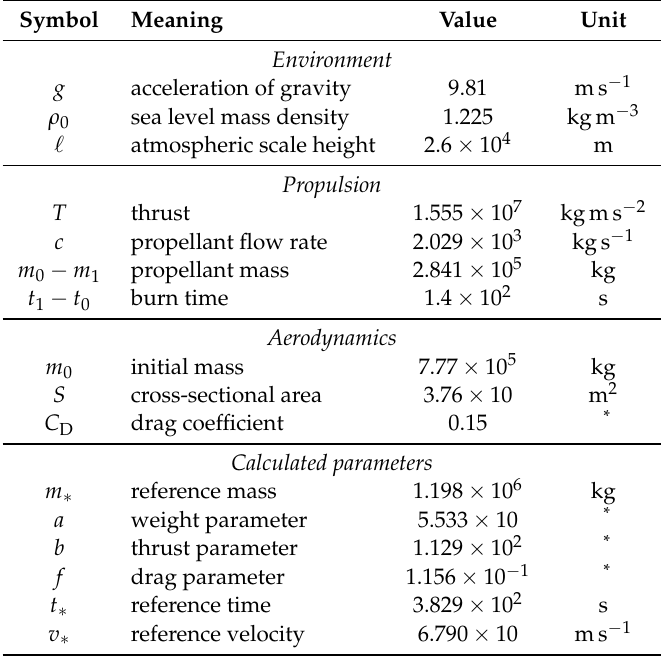
Table 2. Input data for calculations of rocket trajectories by methods I in Section 3, method II in Section 4 and method III in Sections 5.1 and 5.2. Symbol Meaning Value